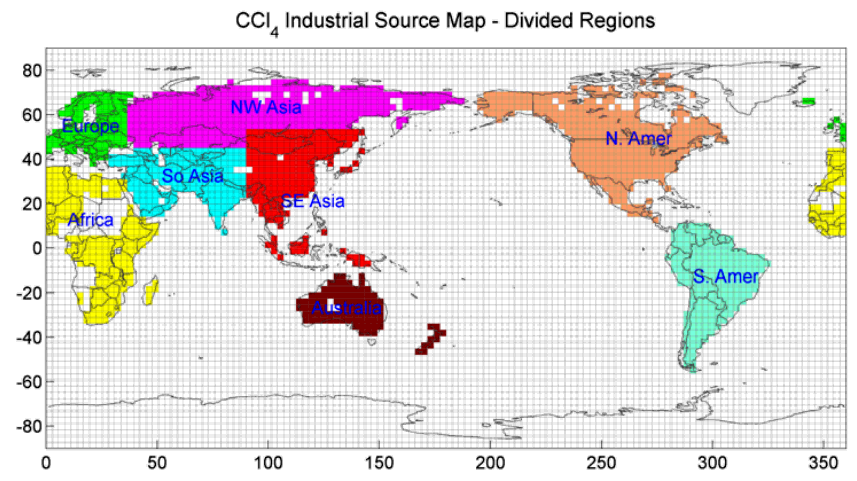
Fig. 3. Partitioning of the global industrial CCl 4 source into the eight regions is shown along with the T42 MATCH grids. The regional source magnitudes are estimated in the Kalman filter as 12-month average values. The spatial distributions (but not total emissions) within each source region and for the ocean sink remain at their a priori distributions in the estimation